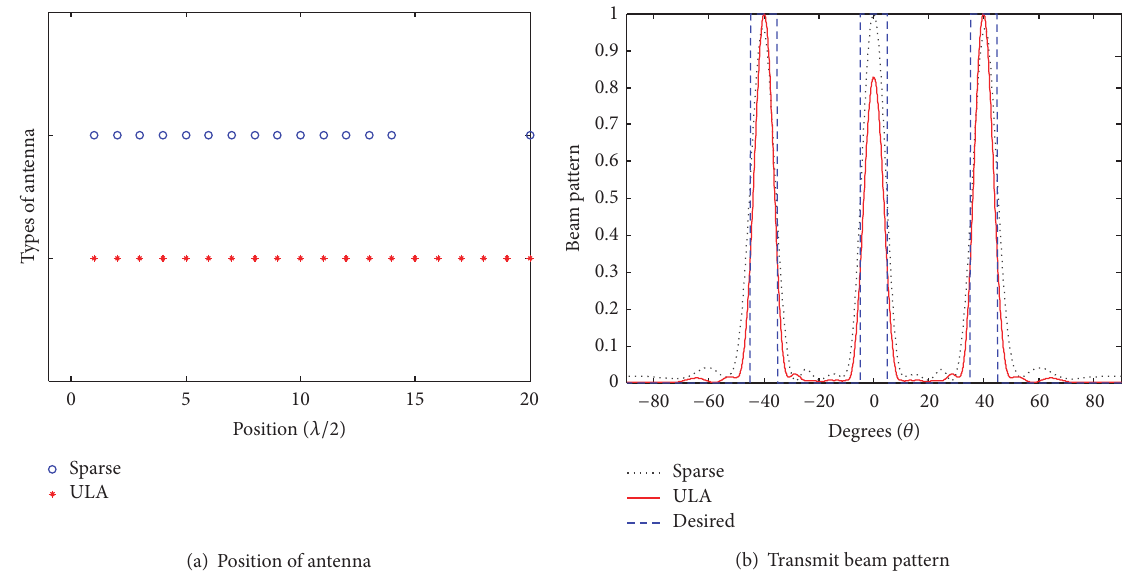
Figure 1: Results of the sparse antenna array using CA+CA, 𝑀 = 15 , and 𝑁 = 20 . The desired beam pattern is represented by the blue dashed